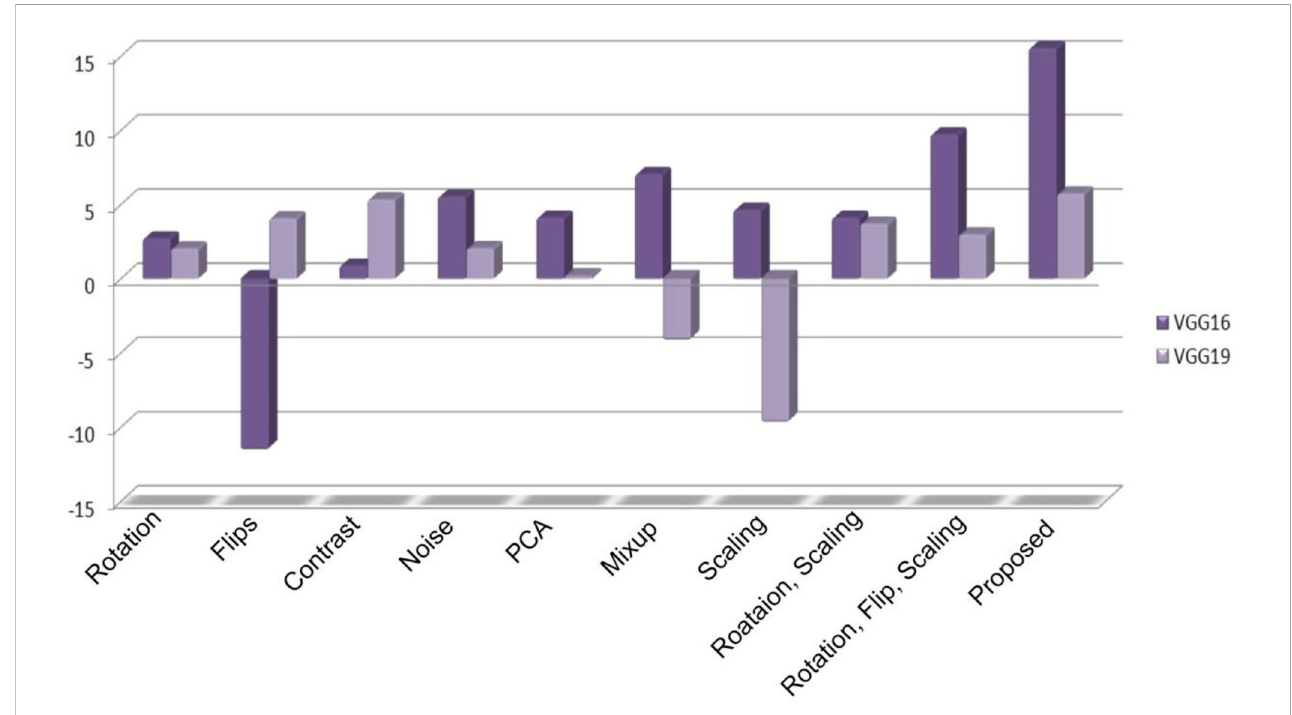
FIGURE 8 Average classi fi cation accuracy obtained by